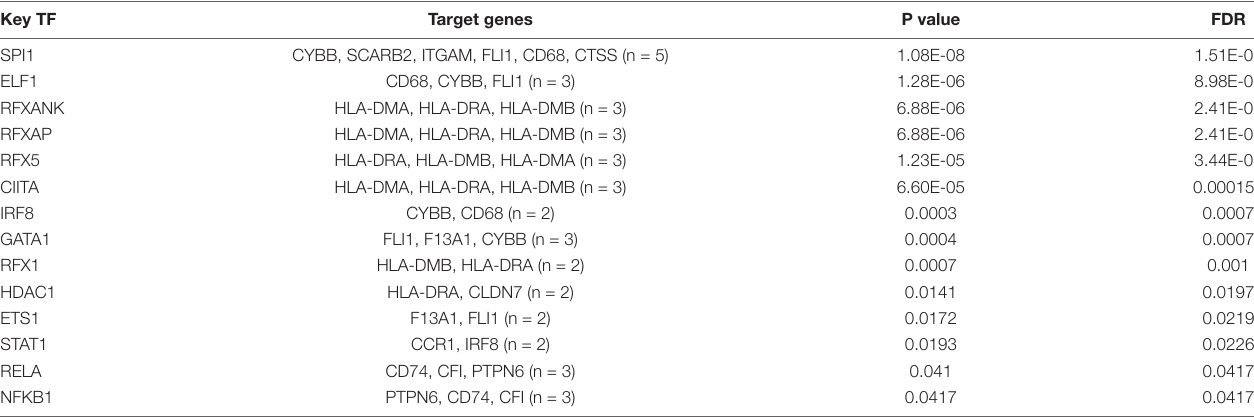
TABLE 3 | Key transcription regulators (TF) targeting the darkgrey module